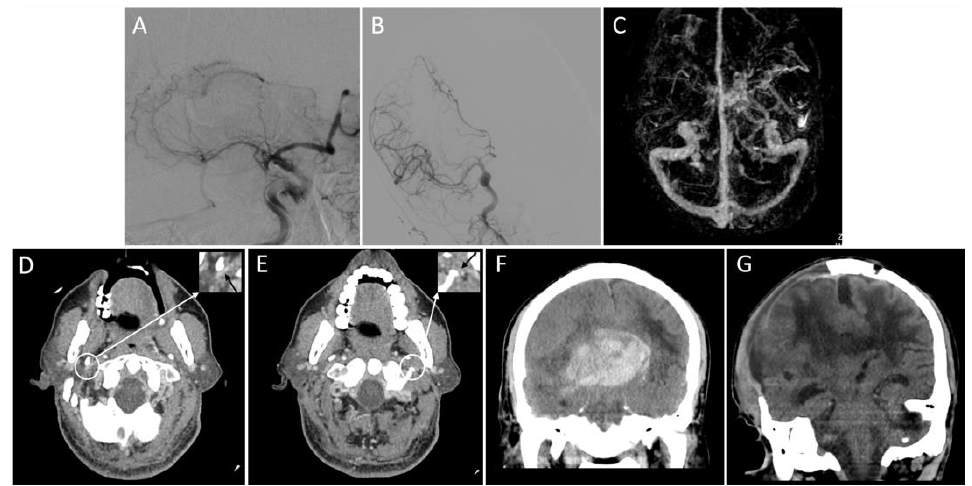
Figure 3. Representative images of the outflow profile of internal jugular veins and outcomes. An adult patient with an acute right middle cerebral artery occlusion ( A ) was admitted with a National Institutes of Health Stroke Scale score of 19. The patient received a thrombectomy for 6 h following stroke onset and achieved successful reperfusion (modified thrombolysis in cerebral infarction score = 3) ( B ). Three-dimensional reconstructed computed tomography (CT) venography shows that the right transverse sinus is larger than the left ( C ), and bilateral internal jugular veins are severely narrowed on the axial CT angiography ( D , E , black arrows). On the non-contrast CT scan within 24 h after thrombectomy, a parenchymal hematoma, midline shift, and subfalcine hernia are present ( F ). Sixteen days after thrombectomy (15 days after decompressive craniectomy), there is an apparent cerebral edema ( G ). The patient’s modified Rankin Scale score at discharge is 5.